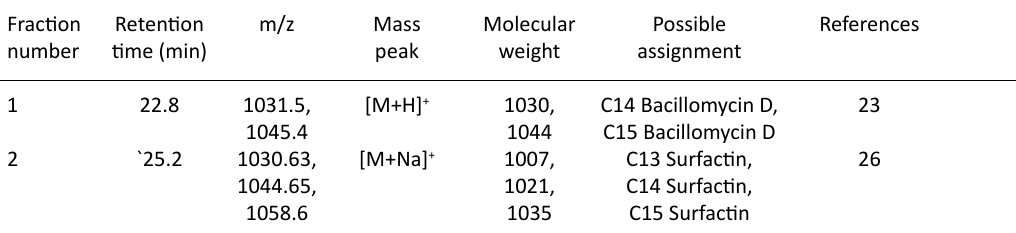
Table 1. Lipopeptides produced by B. amyloliquefaciens MTCC 10456 and detected by LC-ESI-MS/MS analysis Fraction Retention m/z Mass Molecular Possible